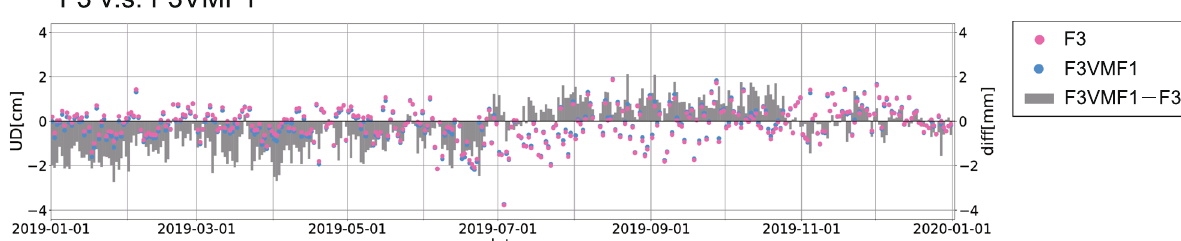
Fig. 13 Comparison of change in the UD baseline vector component at Gusukube with respect to